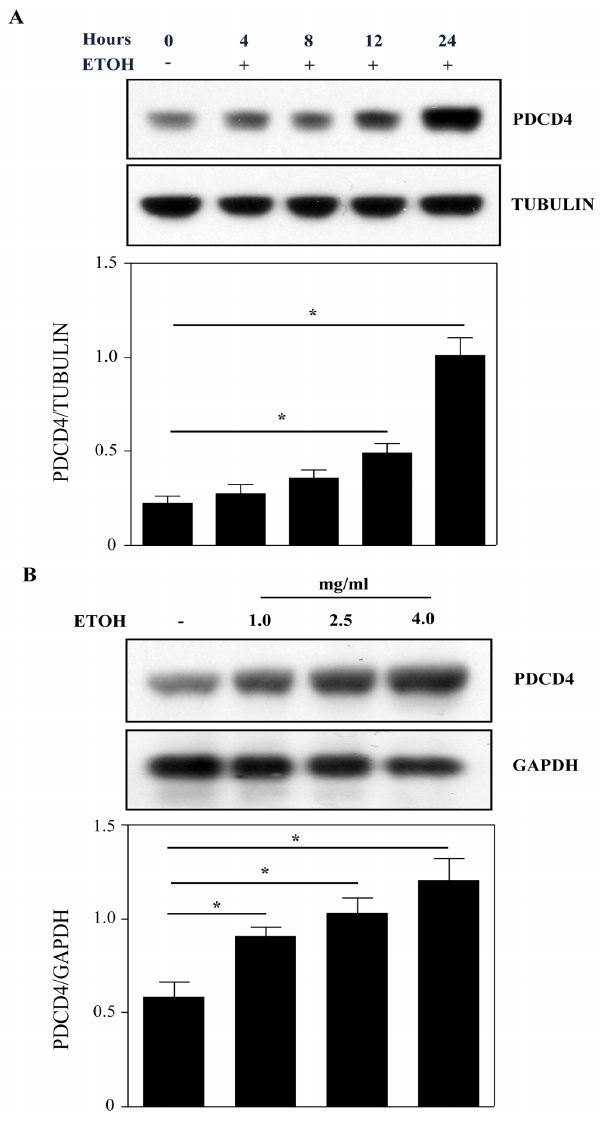
Figure 1. Ethanol time and dose dependently increases PDCD4 expression in cortical neuroblasts. ( A ) Cells were treated with or without ETOH (4 mg/ml) for 4, 8, 12 and 24 h. PDCD4 levels in neuroblasts were evaluated by immunoblot analysis. Anti-tubulin was used to demonstrate equal loading. Lower panel shows densitometric scanning analysis ratio of PDCD4 to tubulin. ( B ) Cells were treated with 1 mg/ml ( , 21 mM), 2.5 mg/ml ( , 54 mM) and 4 mg/ml ( , 86 mM) ethanol for 24 h. Cells were then harvested and immunoblotted with anti-PDCD4 and anti-GAPDH. Protein levels were quantitated using Scion Image software. One-way analysis of variance (ANOVA) and Newman-Keul’s posthoc test was performed to establish statistical significance.*p , 0.05 when compared with untreated control (A & B), n=3.